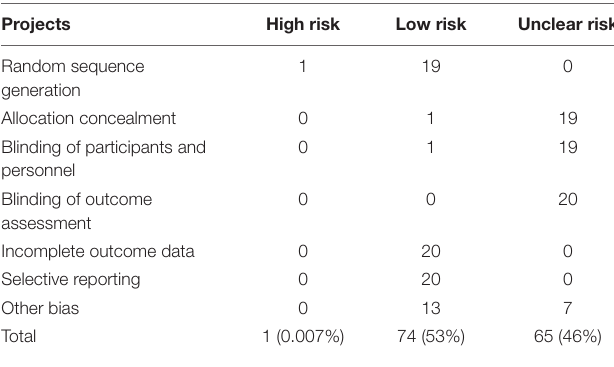
TABLE 3 | Risk of bias evaluation for the included randomized controlled trials (RCTs).